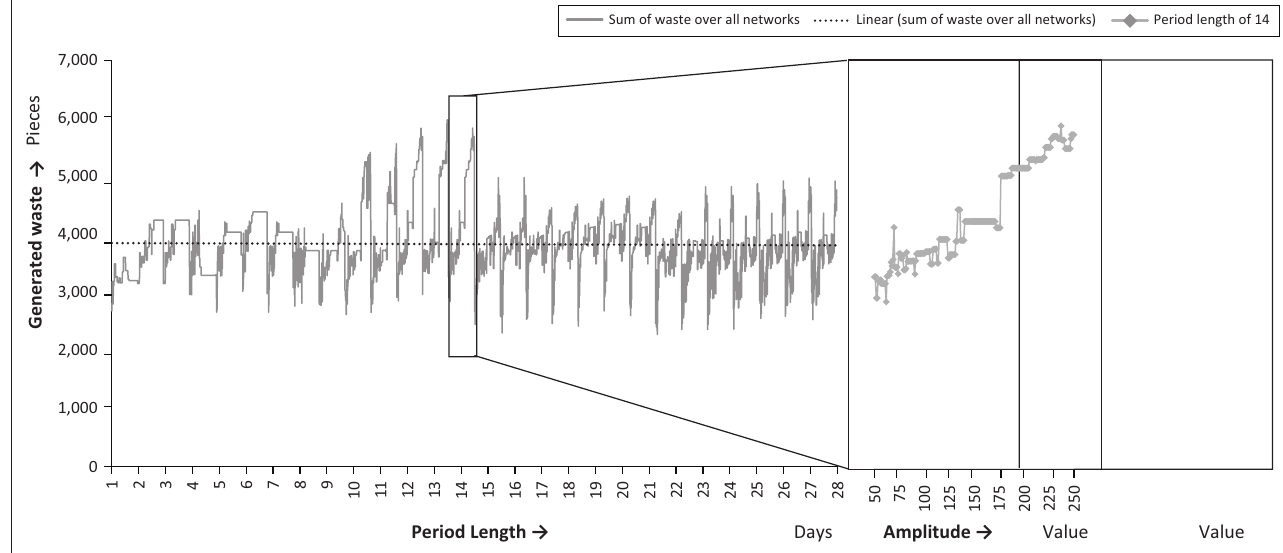
Sum of waste over all networks Linear (sum of waste over all networks) Period length of 14